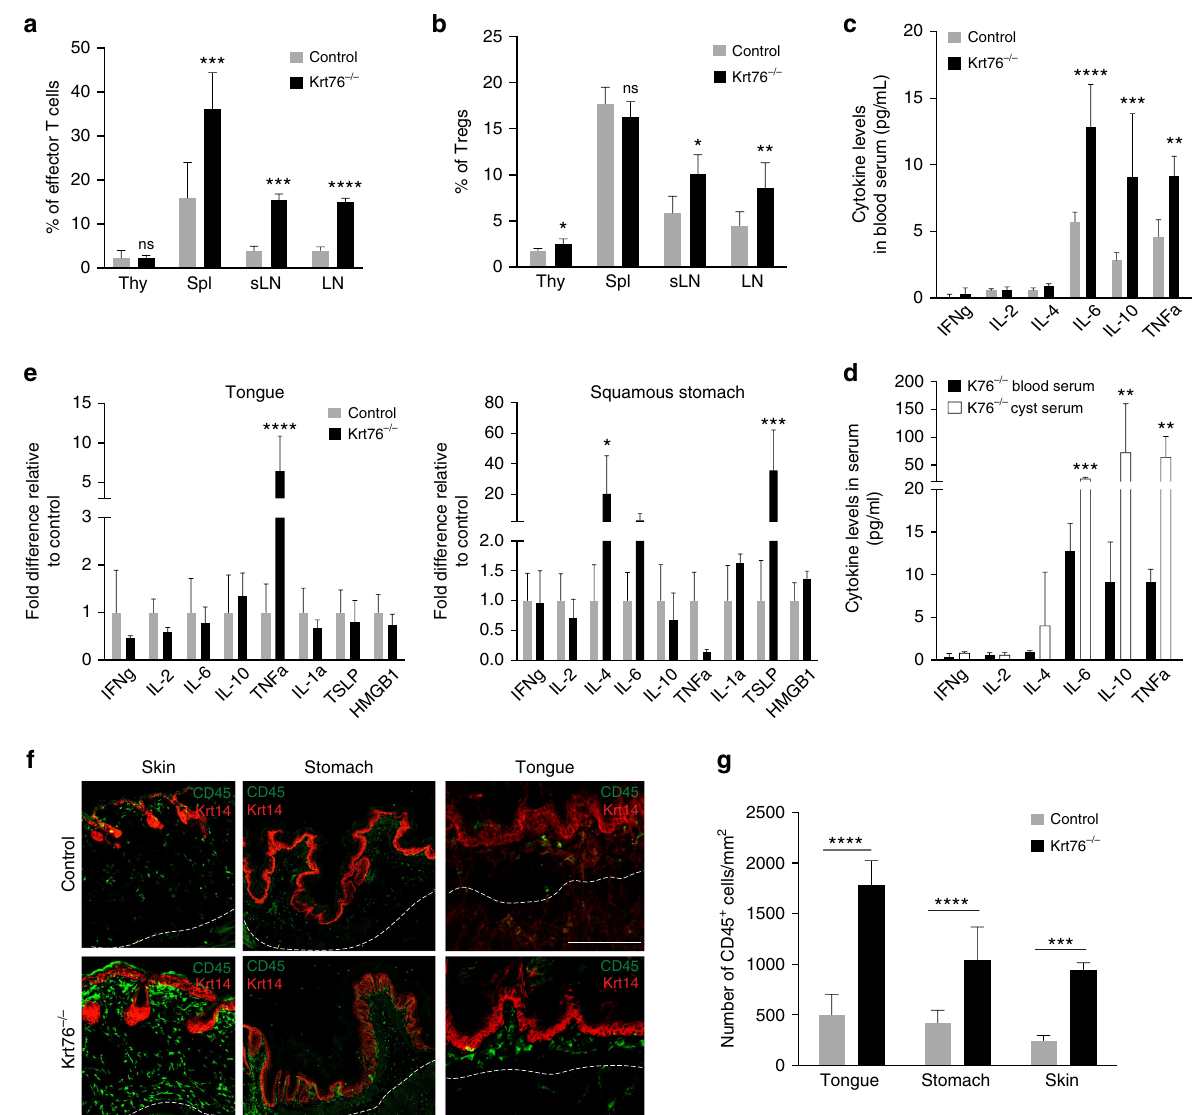
Fig. 3 Loss of Krt76 results in local and circulating increase in cytokines and expansion of Tregs. a, b Summary of fl ow cytometric analysis of % effector T cells (CD44 high CD62L low ) ( a ) and Foxp3 + Tregs ( b ) in total TCR β + CD3 + CD4 + T cells in thymus (Thy), spleen (Spl) and lymph nodes (LN; sLN, submandibular lymph nodes) from control and Krt76 − / − mice ( n = 4 mice/genotype, mean ± s.e.m., unpaired t -test). c, d Levels of cytokines in blood serum ( c ) and cyst fl uid ( d ) of control and Krt76 − / − mice assessed by CBA analysis ( n = 4 mice per genotype; experiment repeated twice, mean ± s.e.m., unpaired t -test). The same blood serum measurements for Krt76 − / − mice are shown in c and d . e Quantitative RT-PCR of cytokine mRNAs, relative to Gapdh, in tongue and squamous stomach epithelia ( n = 4 mice/genotype, mean ± s.e.m. of biological and technical triplicates; unpaired t -test). f, g Representative images of CD45 (green) and Keratin14 (red) stained sections of skin, tongue and squamous stomach epithelia ( f ), and quanti fi cation of in fi ltrating CD45 + leucocytes/mm 2 of stromal region ( g ). Stromal region corresponds to area between the epithelium and the white dotted line; n = 3 mice per condition, 2 sections per mouse and >4 microscopic views per mice, means ± s.e.m., *** p ≤ 0.001, **** p ≤ 0.0001, unpaired t-test). * p ≤ 0.05; ** p